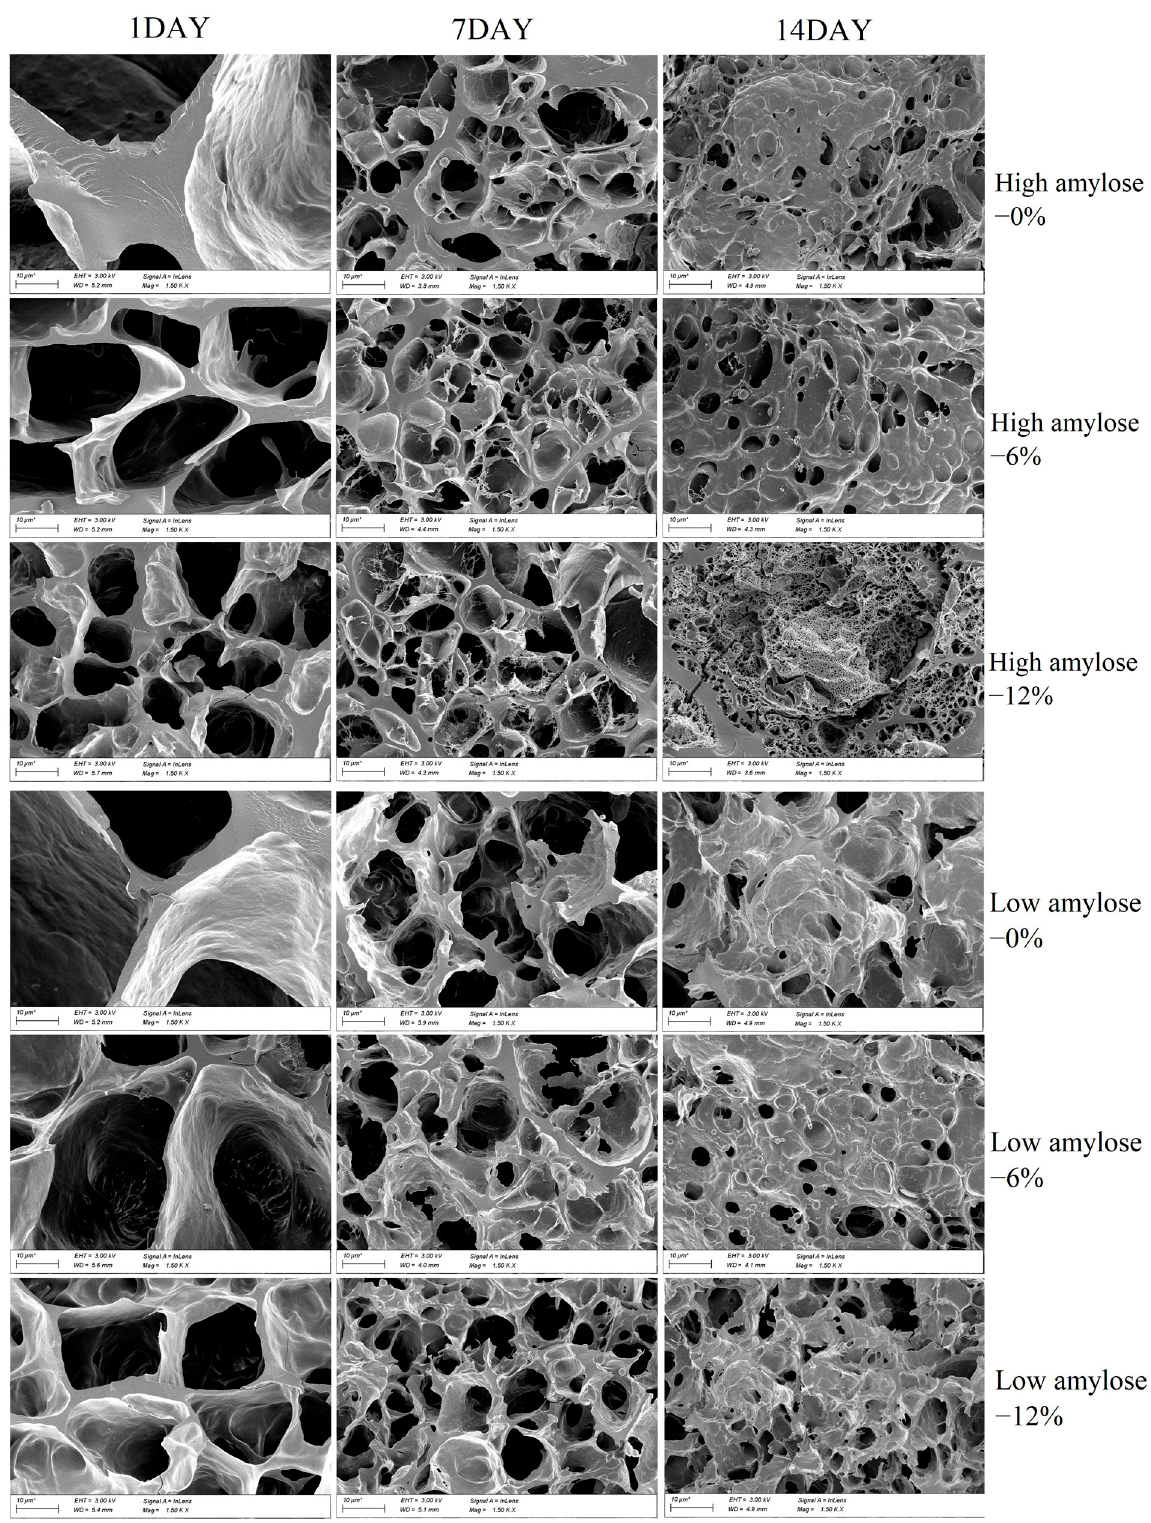
Figure 2. SEM images of the high-amylose and low-amylose RRF gels were added with different protein fractions (wt%). The magnification is 2000 times. High-amylose RRF contained 25.9% amylose; low-amylose RRF contained 13.8%